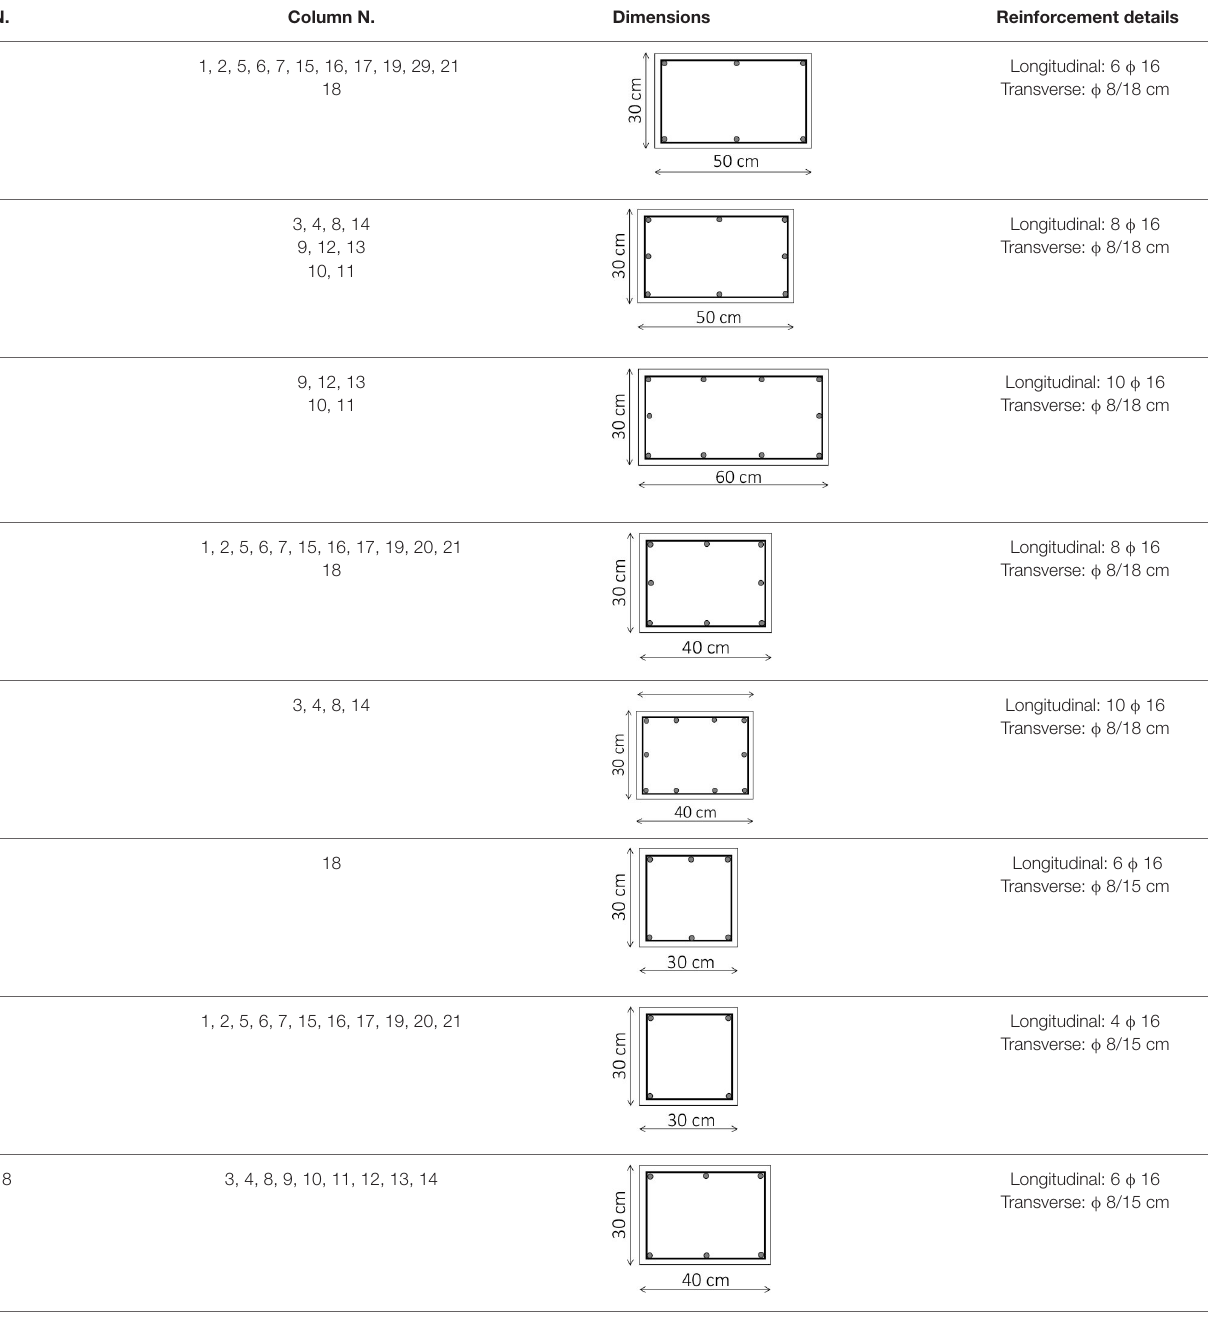
TABLE 1 | Existing columns. Floor N. Column N.